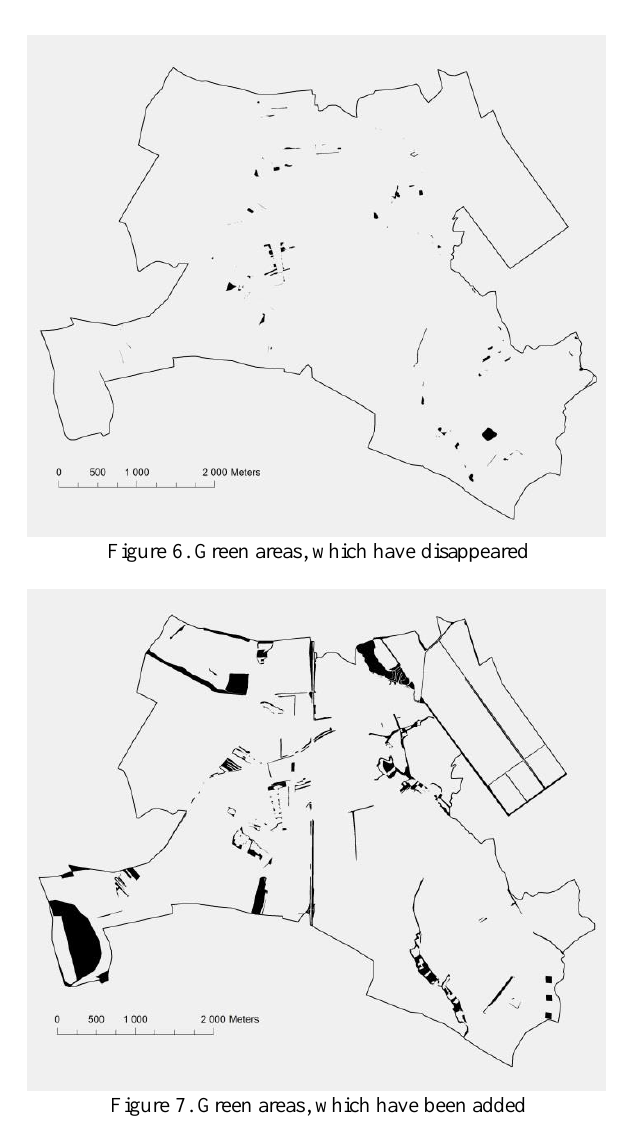
Figure 7. Green areas, which have been added